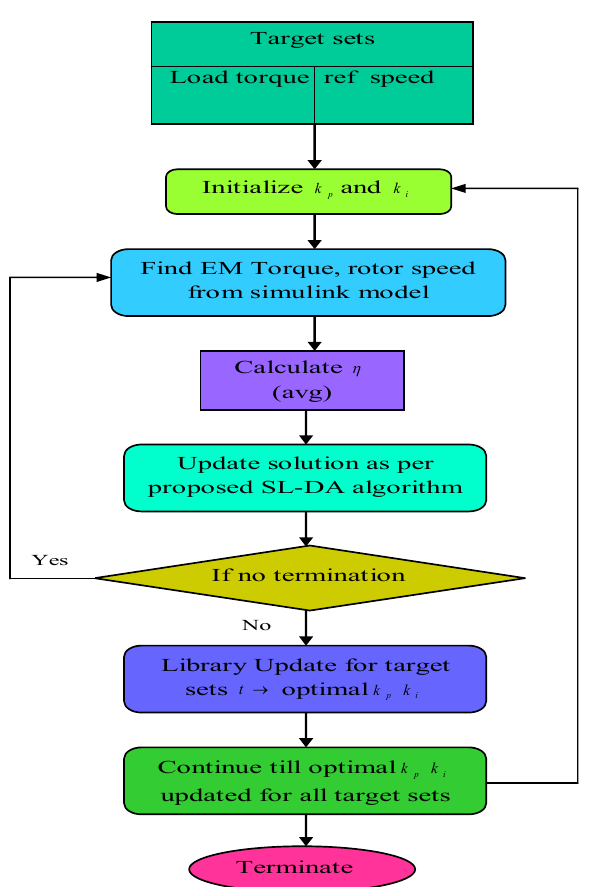
Figure 5. Procedure adopted for gain update in PI controller of speed-control block.